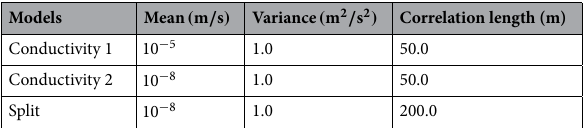
Table 1. The statistical parameters used to generate the hydraulic conductivity